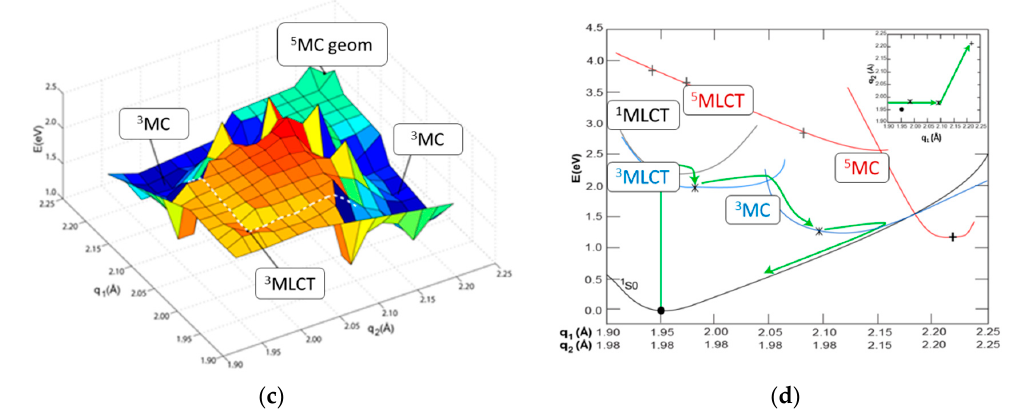
Figure 6. Photophysics of complex 1 . ( a ) Transient absorption kinetics of complex 1 following 480 nm excitation, recorded at 455 nm (blue squares) in the ground-state bleach region and at 525 nm (red circles) at the excited state absorption maximum. ( b ) molecular orbital diagram with selected Kohn-Sham (KS) orbitals displayed from B3LYP*/6-31G(d) Density Functional Theory (DFT) calculations of 1 in an implicit solvent model for MeCN. ( c ) Calculated triplet potential energy surface. ( d ) Projected potential energy surface plot of key ground as well as triplet and quintet excited states involved in the proposed deactivation cascade which is indicated by green arrows; ( c ) and ( d ) adapted with permission from Fredin et al. [44] Copyright 2014 American Chemical Society.